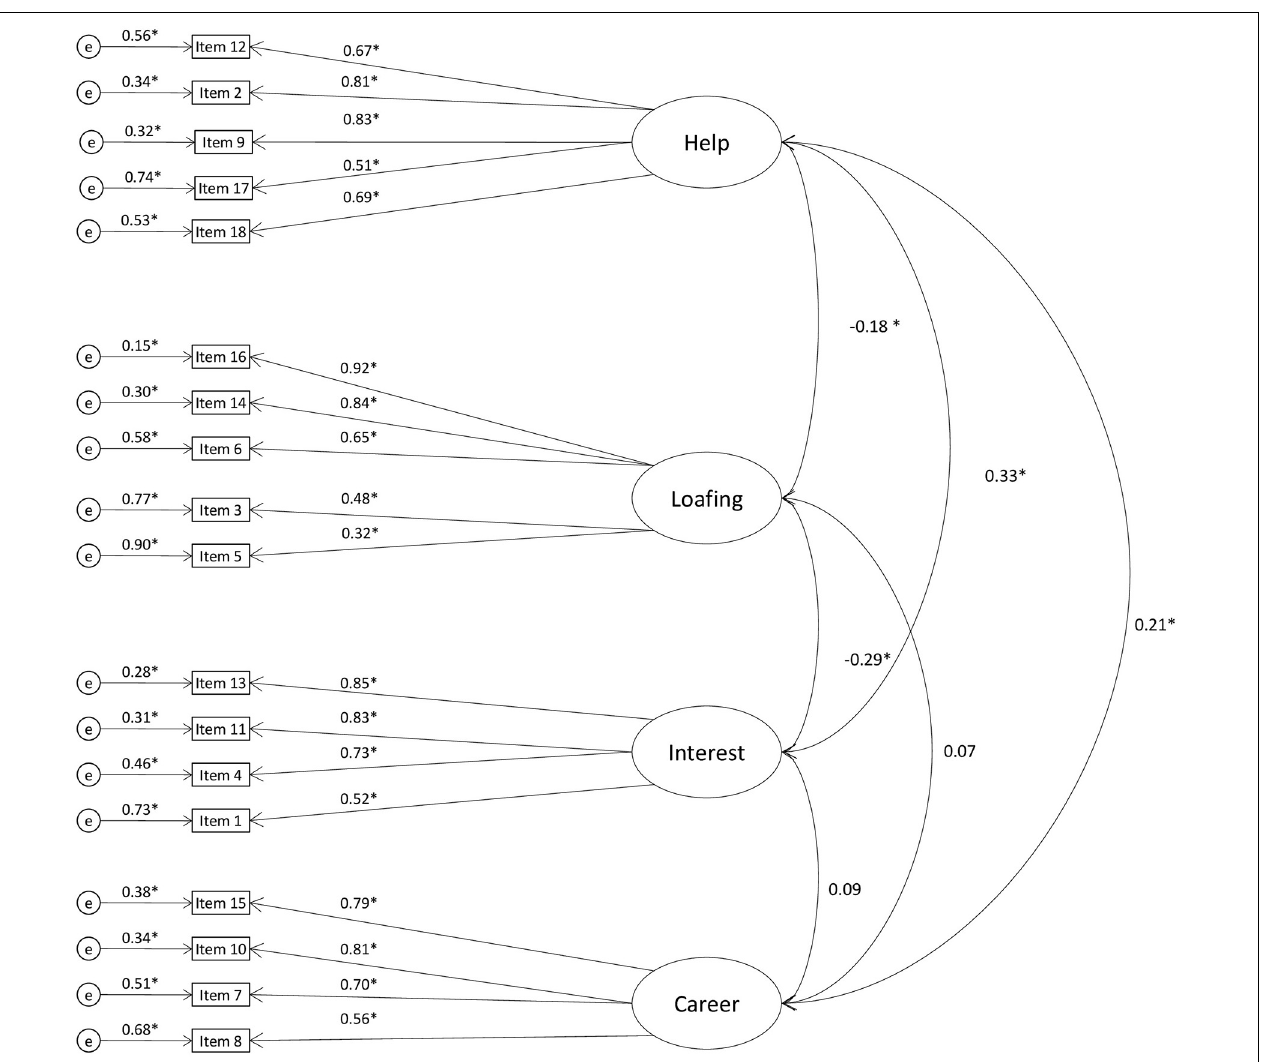
FIGURE 2 | CFA model with standardized estimates: MICC, Sample 2 ( N = 896).